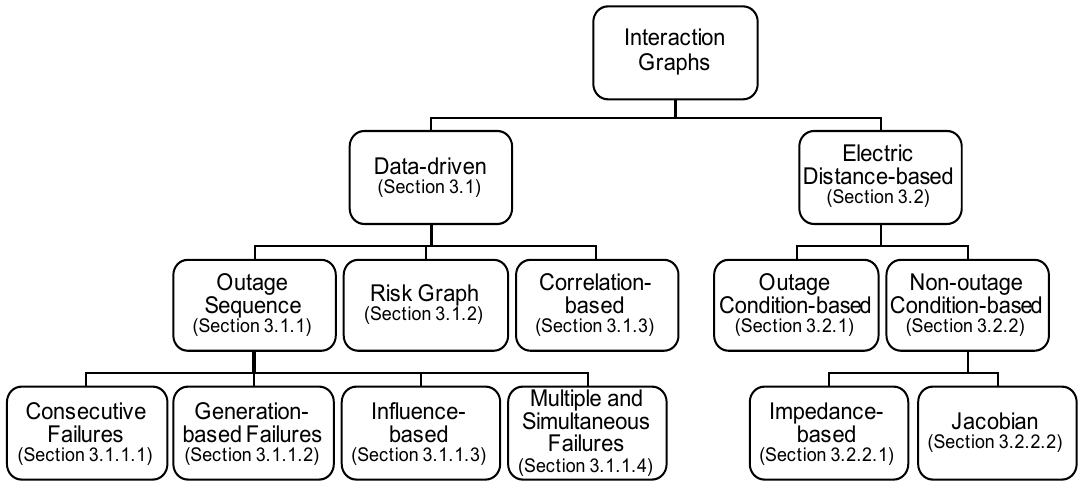
Figure 1. Taxonomy of methods for constructing interaction graphs with section numbers shown for the categories and